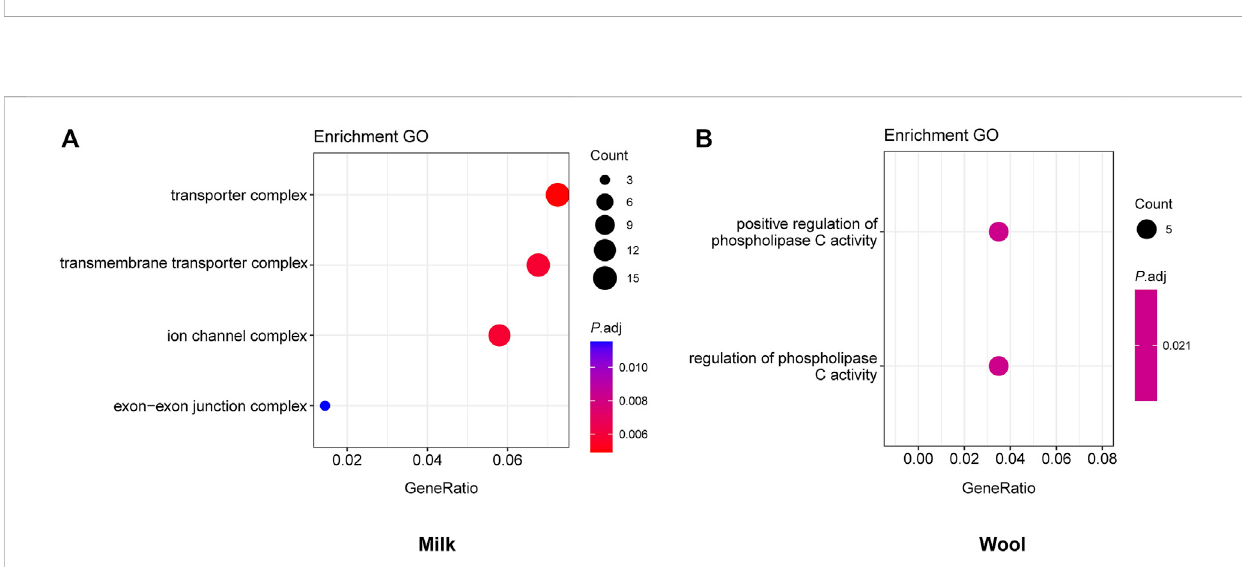
FIGURE 2 Manhattan plot of θ π ratio and F ST for wool traits. The vertical gray thick lines indicated the position of selected genes detected in our study. The top 5% threshold ( F ST = 0.228, θ π ratio = 0.064) values are denoted by blue horizontal dashed lines.